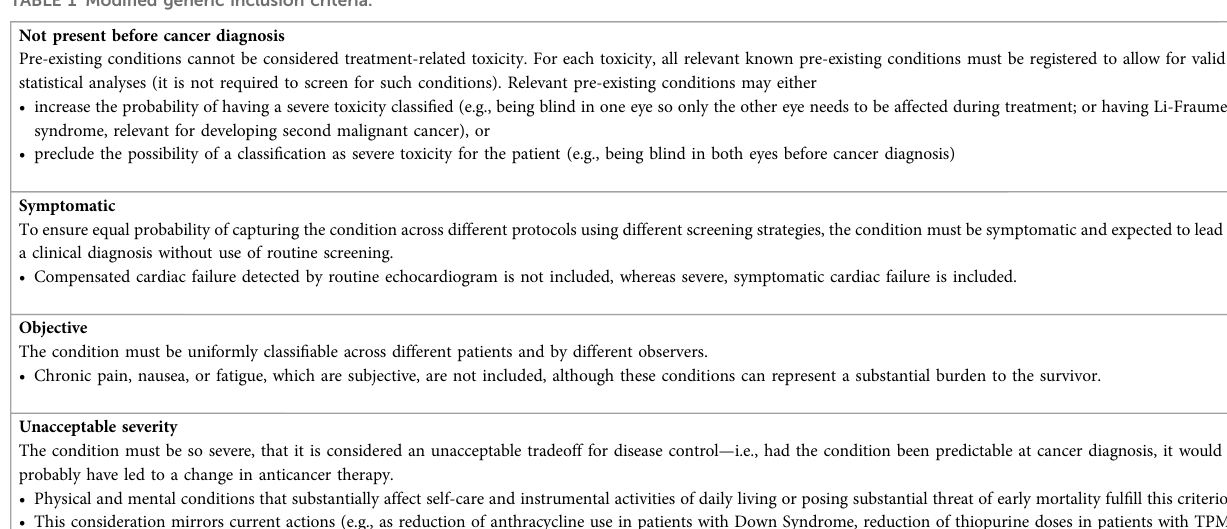
TABLE 1 Modi fi ed generic inclusion